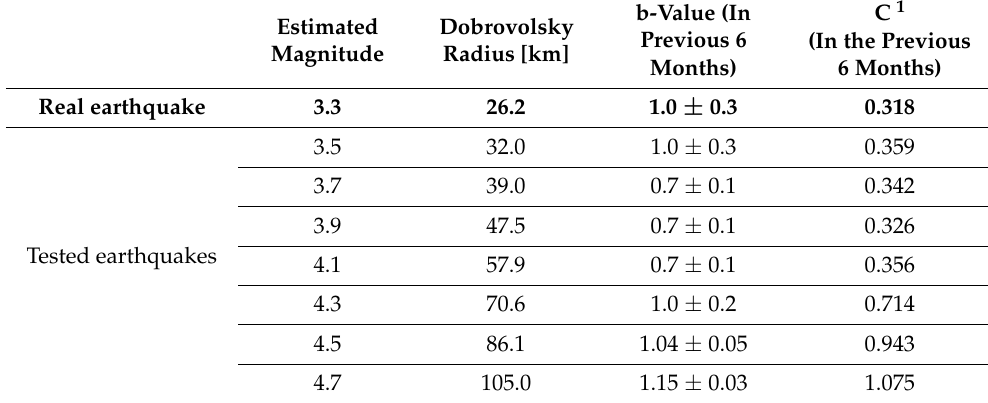
Table 1. List of the real (in bold) and tested earthquake magnitudes with the corresponding Dobro- volsky’s radius. All the events are centred at the epicentre of the ML3.3 Guidonia 1 January 2023 earthquake (41.982 ◦ N, 12.750 ◦ E). The b-value of the Gutenberg–Richter distribution is computed during the six months before the Guidonia earthquake by the maximum curvature method, and details and graphs are provided in Supplementary Materials Figure